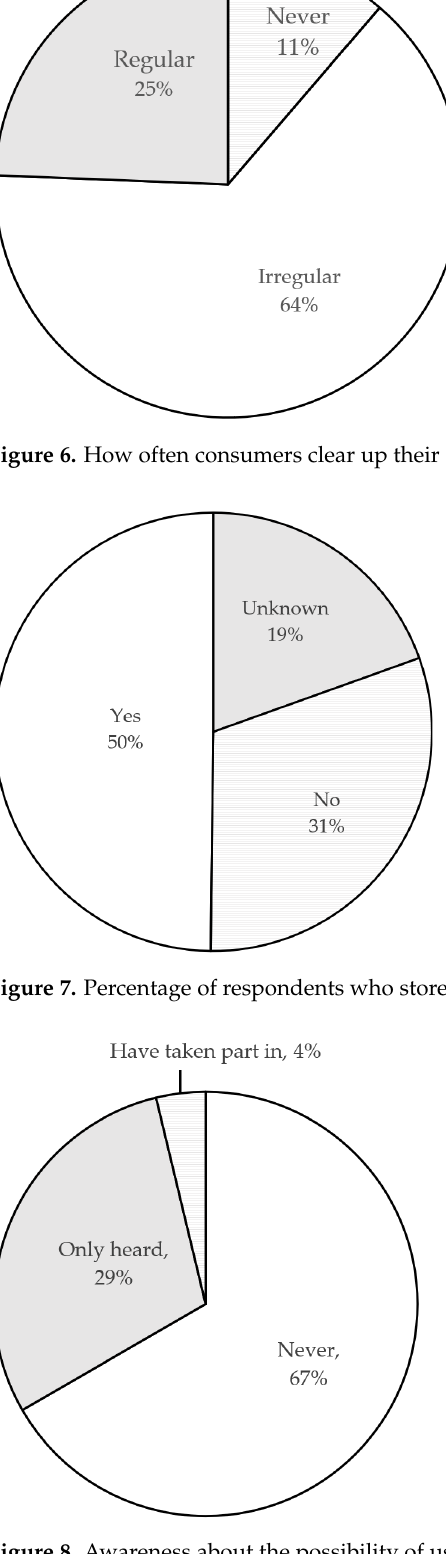
Figure 8. Awareness about the possibility of used drugs